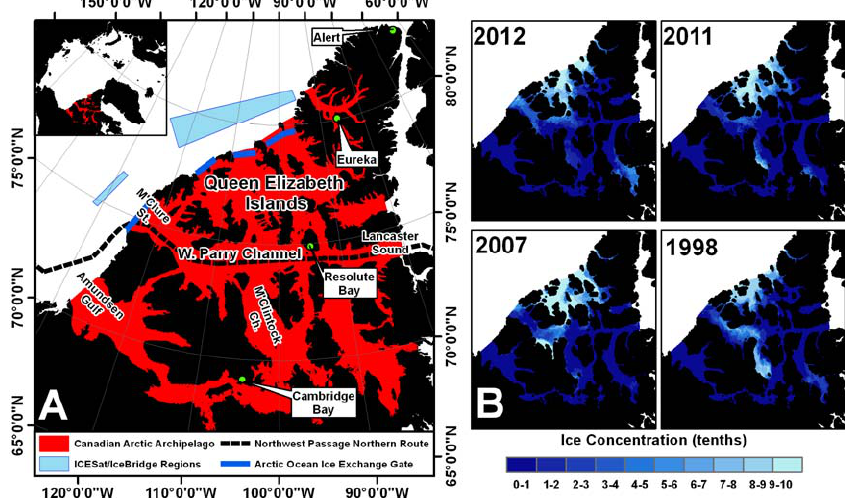
Figure 1. The geographical location of the Canadian Arctic Archipelago (CAA) (A) and spatial distribution of CAA mean September total ice concentration (tenths) for the four extreme light years (B).